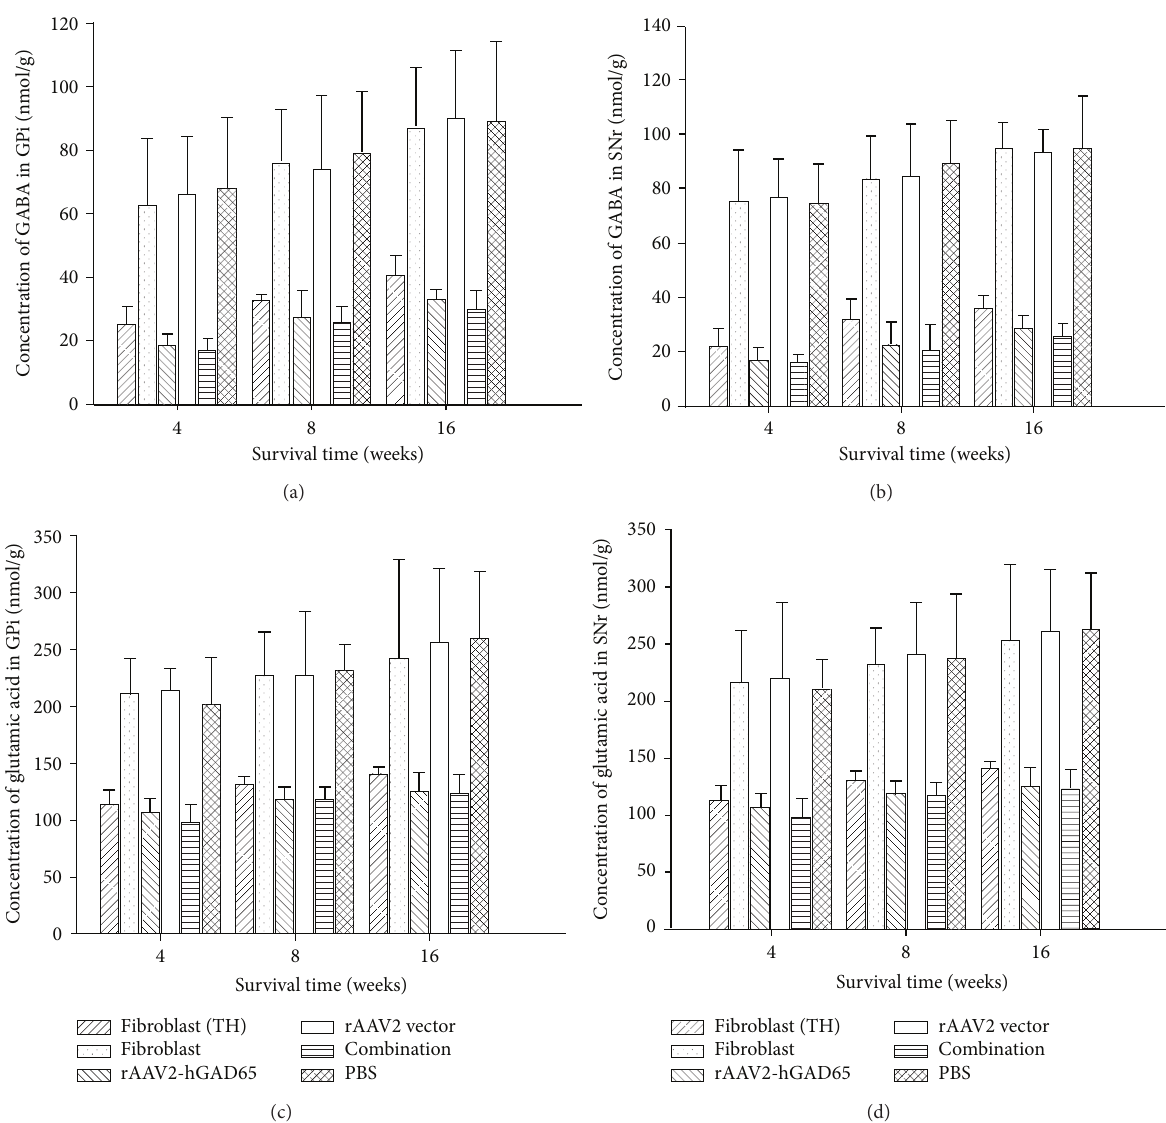
Figure 6: GABA and glutamic acid concentrations in the GPi and SNr tissues. (a and b) The concentrations of GABA in the GPi and SNr tissues of combination group were a little lower than that of rAAV2-hGAD65 and fibroblasts (TH) groups ( 𝑃 > 0.05 , 𝑛 = 6 ). But the GABA concentrations in these three groups were all obviously lower than that of the three control groups (fibroblasts, rAAV2 vector, and PBS) at 4, 8, and 16 weeks after treatment ( 𝑃 < 0.01 , 𝑛 = 6 ). (c and d) The changing tendency of the concentration of the glutamic acid was similar to the change of the GABA in GPi and SNr at the 4, 8, and 16 weeks after treatment ( 𝑃 > 0.05 , 𝑛 = 6 ). Fibroblasts (TH), fibroblasts transferred by rAd-TH; fibroblasts, the primary cultured fibroblasts; rAAV2-hGAD65, recombinant adeno-associated virus particles containing human glutamic acid decarboxylase 65; rAAV2 vector, control adeno-associated virus pedicles; combination, rAAV2-hGAD65 + fibroblasts (TH); PBS, inject the PBS into the